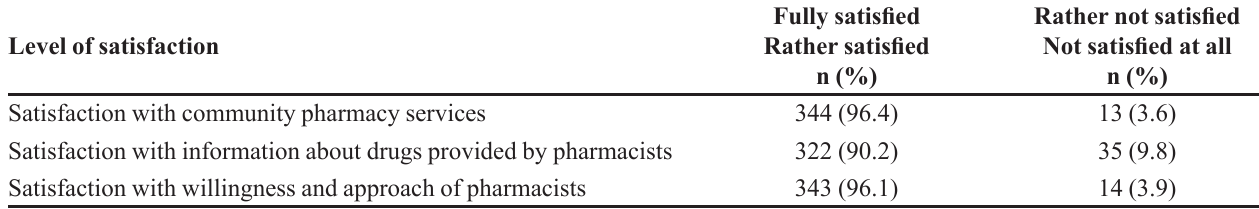
Level of satisfaction